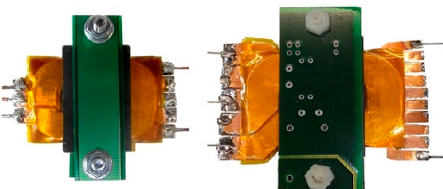
Figure 13. Transformers size comparison. ( left ) 1 MHz planar transformer (E 32/6/20-3F4) and ( right ) 100 kHz planar transformer (E38/8/25-3F3).